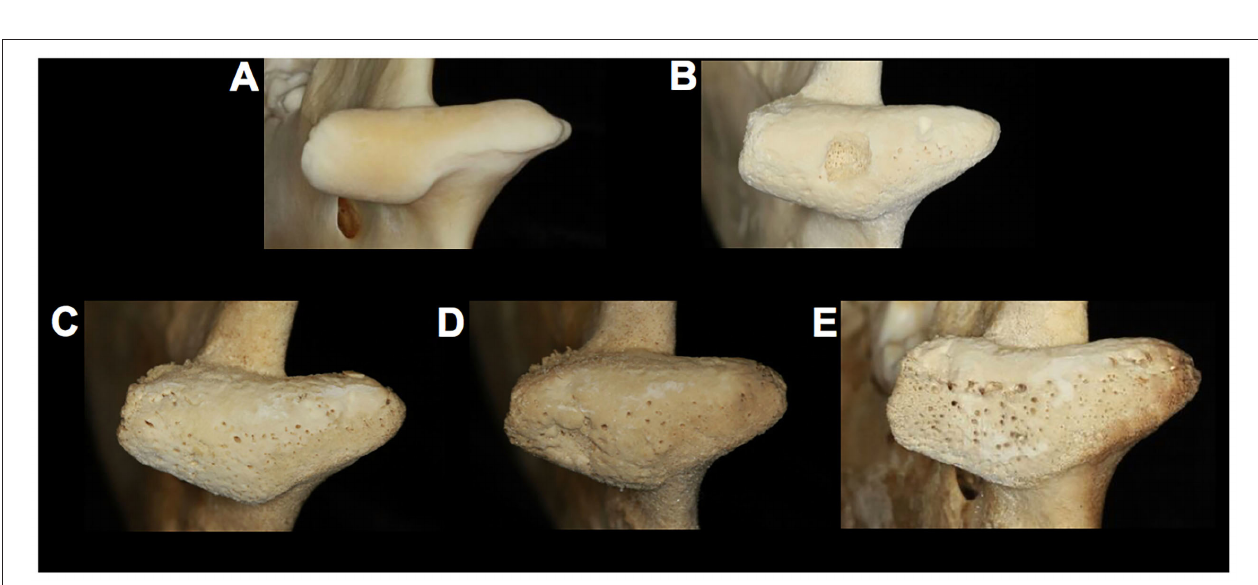
FIGURE 4 | Comparison of gray wolf ( Canis lupus) temporomandibular joints. (A) a healthy right mandibular head (UAM115902, unknown sex) with diseased right mandibular heads displaying (B) a severe central OCD-like lesion (UAM 70583, male) and (C) mild OA (UAM 87890, female), (D) moderate OA (UAM 87884, female) and (E) severe OA of the entire mandibular head (UAM 102040, unknown sex).